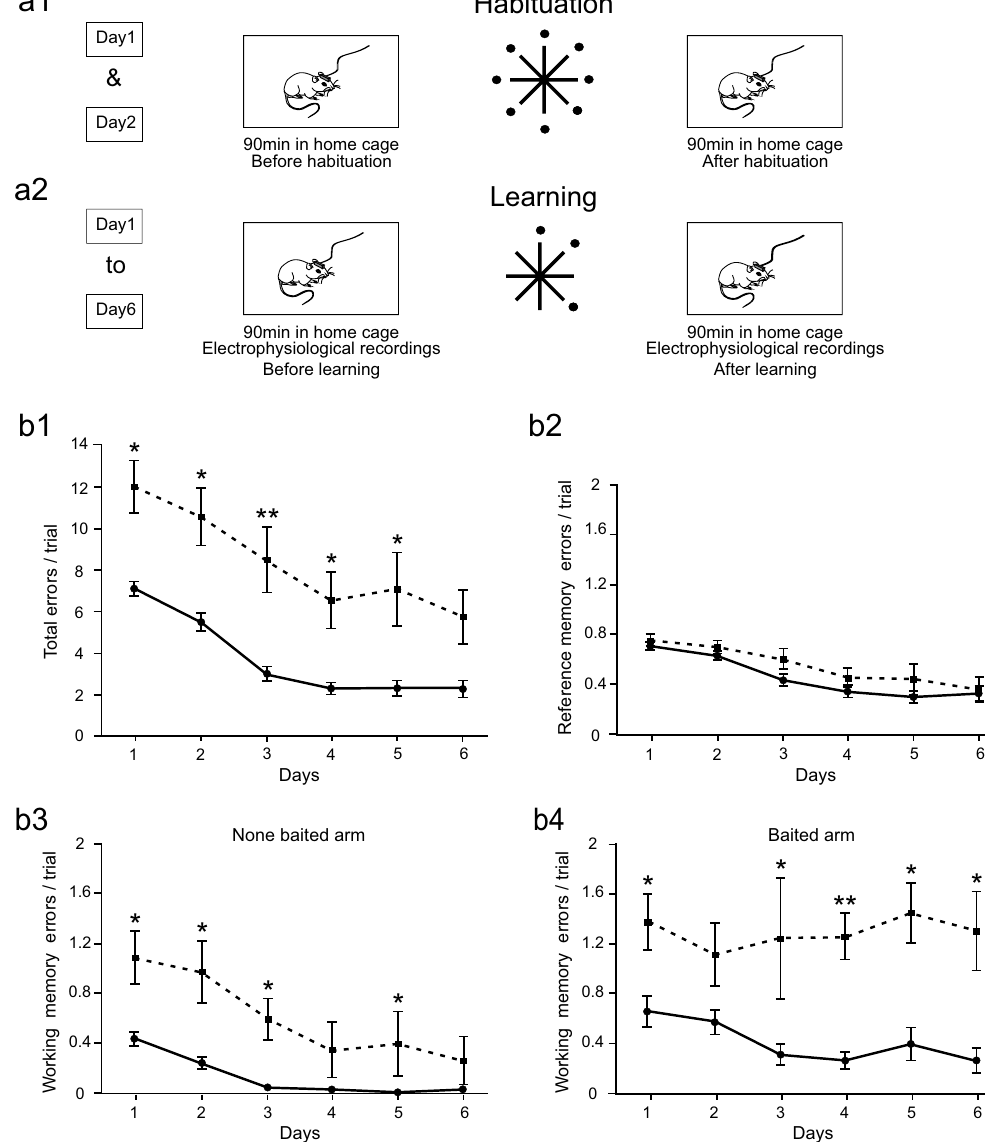
Figure 1. APP-PS1 mice express impairment of working but not reference memory in 8-arm maze spatial memory test. ( a1-2) Schematic representation of experimental paradigm. ( a1 ) The animals were exposed to the experimental set up in their home cage and connected to the recording device before and after visiting the maze, where all the arms were baited. A daily learning session consisted in 6 trials repeated during 6 consecutive days. In each trial the animal had to find the position of 3 baited arms. Electrophysiological recording was performed in the home cage during 90 minutes before and after learning ( a2 ). ( b1 ) Evolution of total memory errors highlighting similar speed of learning in both groups and poorer performance in APP-PS1 mice (P < 0.05 on days 1-5, Wilcoxon rank-sum with Bonferroni correction). ( b2) Acquisition of reference memory is similar in both groups (P > 0.05 on days 1-6, Wilcoxon rank-sum with Bonferroni correction). ( b3) Repetitive visits to none-baited arms were reduced during learning in WT but not APP/PS1 group (WT: N = 7, chi-sq = 29.89, P = 0.000; APP/PS1: N = 7, chi-sq = 7.55, P = 0.183, Friedman’s test), APP-PS1 expressing ~1 error /trial